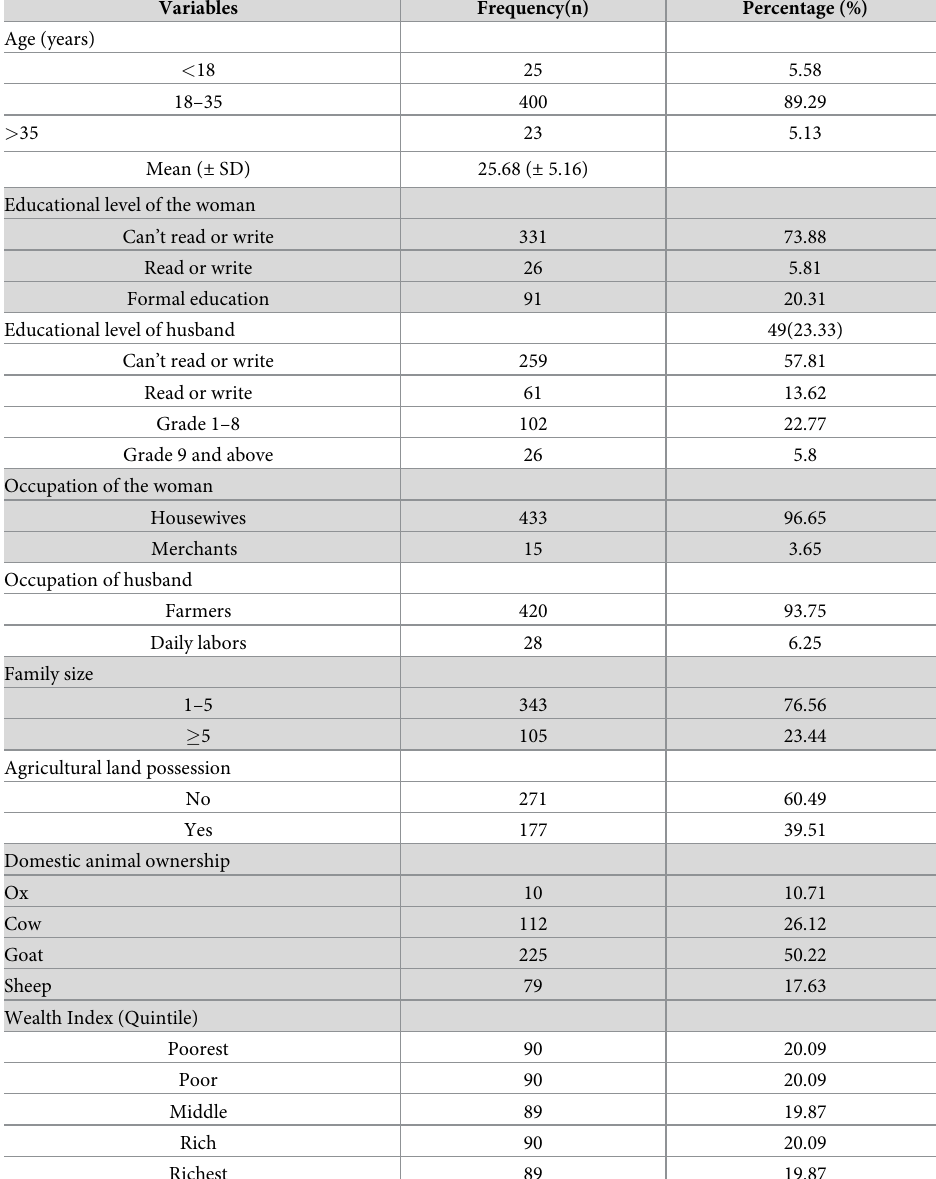
Table 1. Socio-demographic of pregnant women in Haramaya District, eastern Ethiopia, 2021 (n = 448).